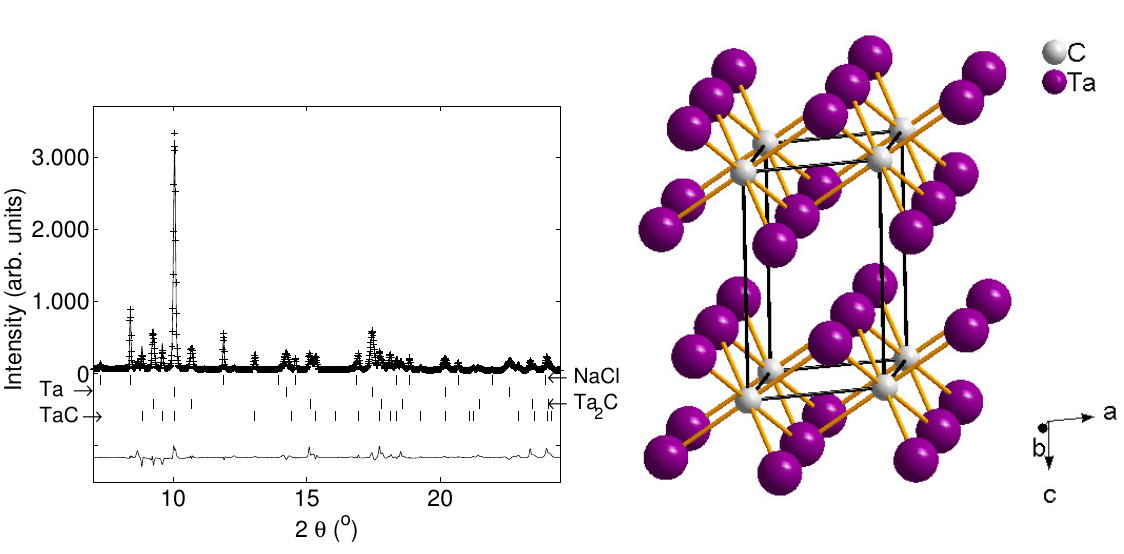
Figure 13. Left: X-ray diffraction pattern ( λ = 0.4130 ˚ A) of the recovered sample of TaC and Ta C after laser heating at 11 GPa. Right: Crystal structure of Ta 2 structure